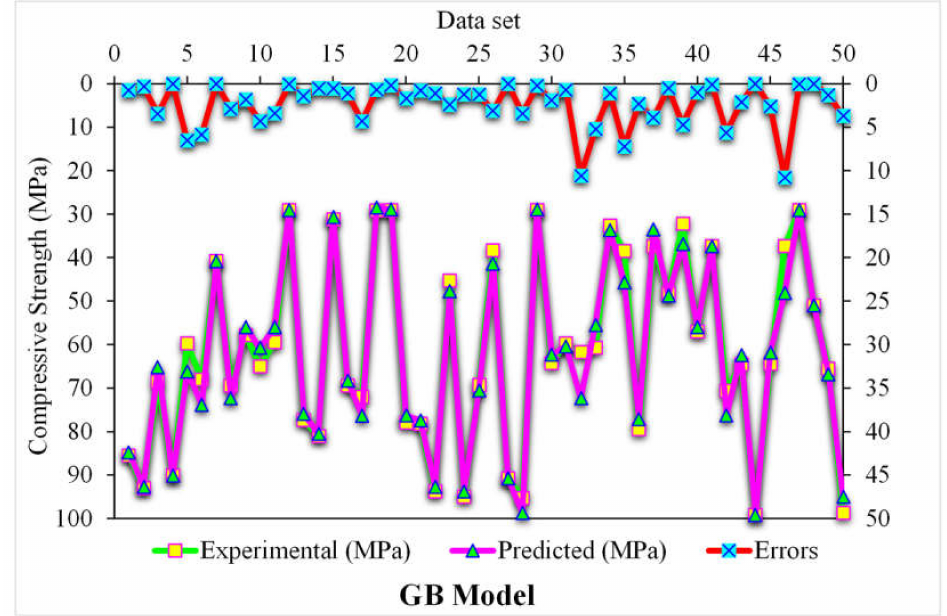
Figure 10. Experimental and gradient boosting predicted values with errors.